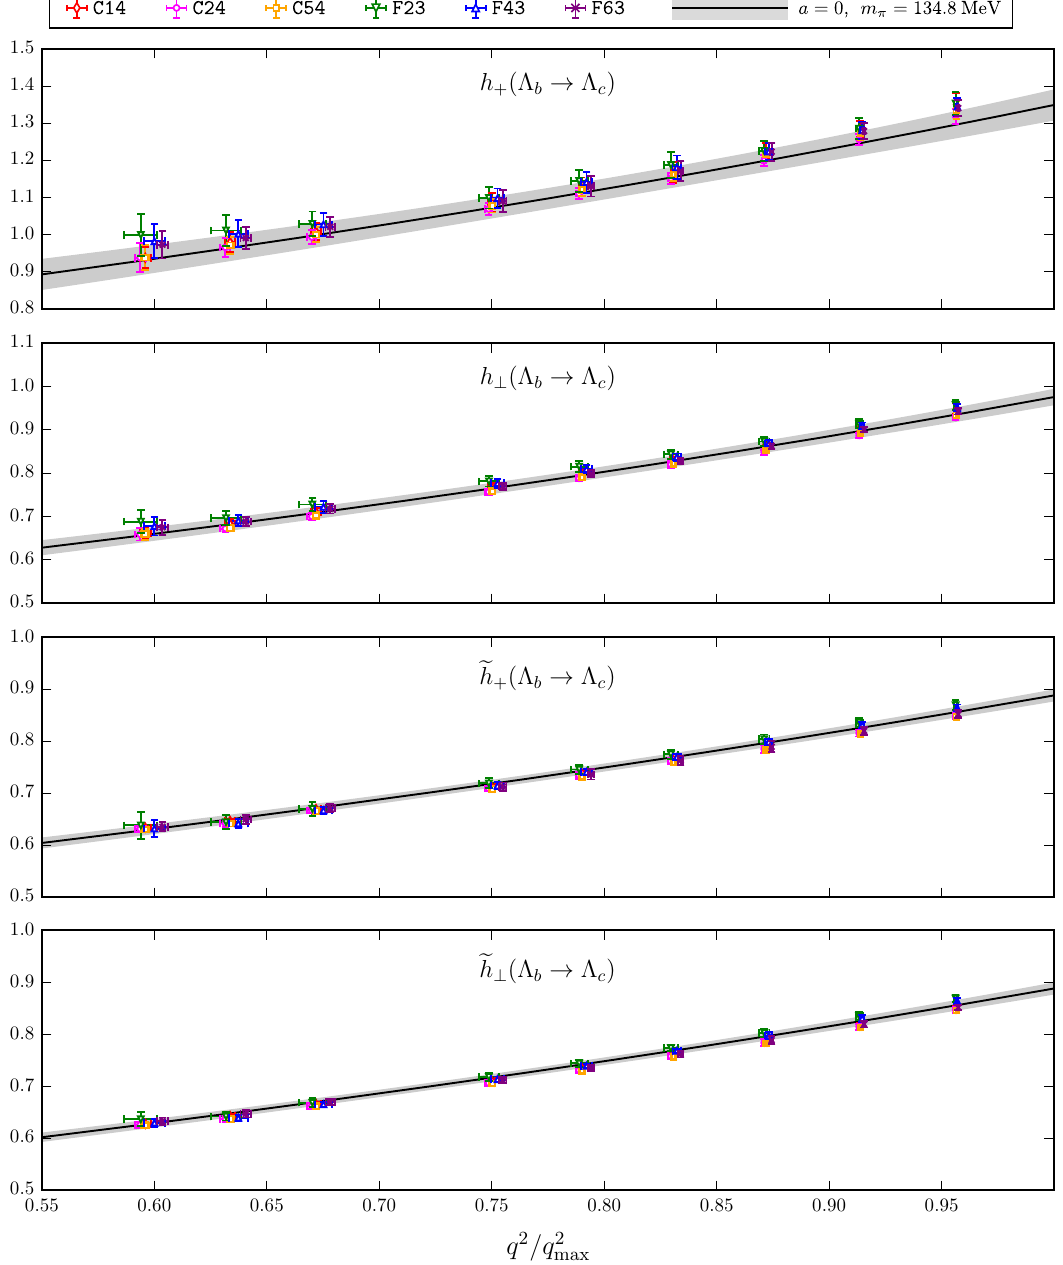
Figure 1 . Λ b Λ c tensor form factors in the high q 2 -region: lattice results and extrapolation to → the physical limit (nominal fit). The bands indicate the statistical uncertainty. The lattice QCD data sets are labeled as in ref.